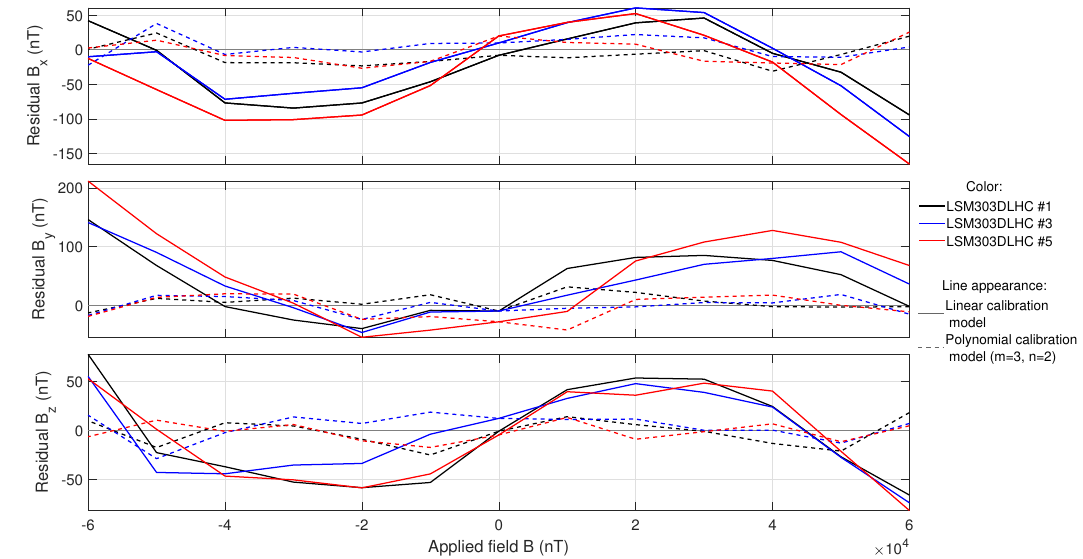
Figure 5. Comparison of on-axis residual fields in coil coordinates, for the two different calibration models, for three of the five LSM303DLHC